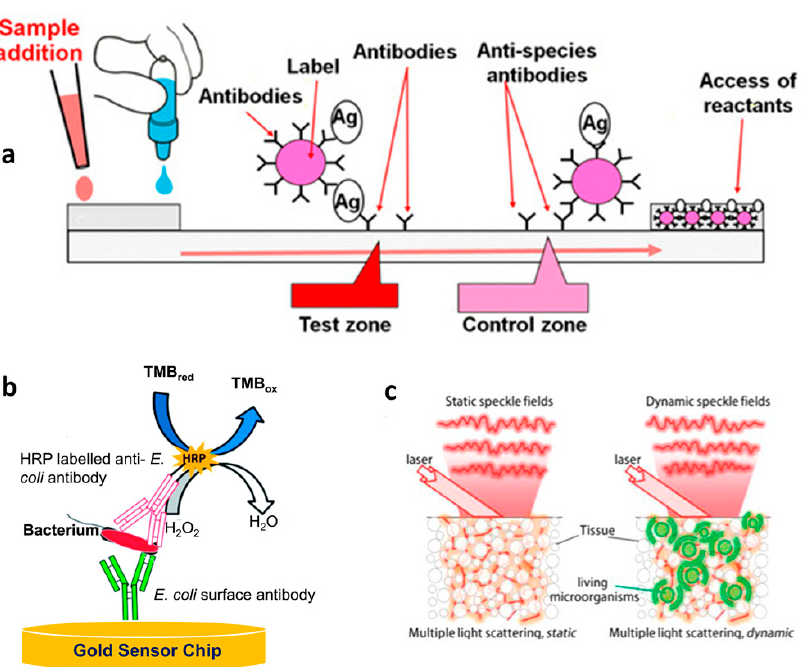
Figure 5. ( a ) Schematic of lateral-flow test strips (LFTS), where the development of a visible line in the testing zone indicates the presence of the target bacteria. Reproduced with permission from